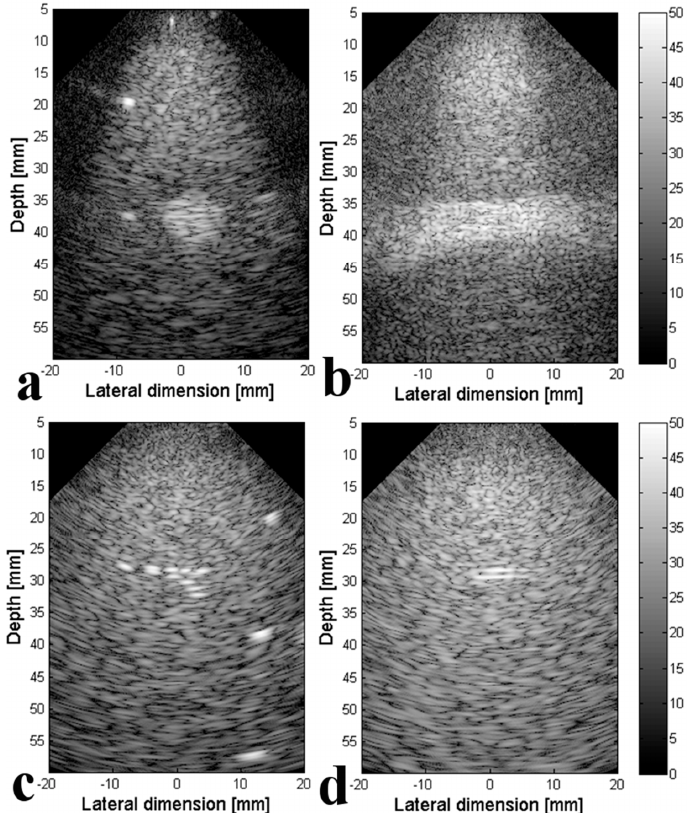
Figure 4. Experimental data obtained for the Gammex phantom with 1024 active elements in ( x , z ) ( a , c ) and ( y , z ) ( b , d ) planes on a cyst ( a , b ) by using 9 PW and “grappe” wires ( c , d ) by using 9 DW. A dynamic of 50 dB has been used in all images.